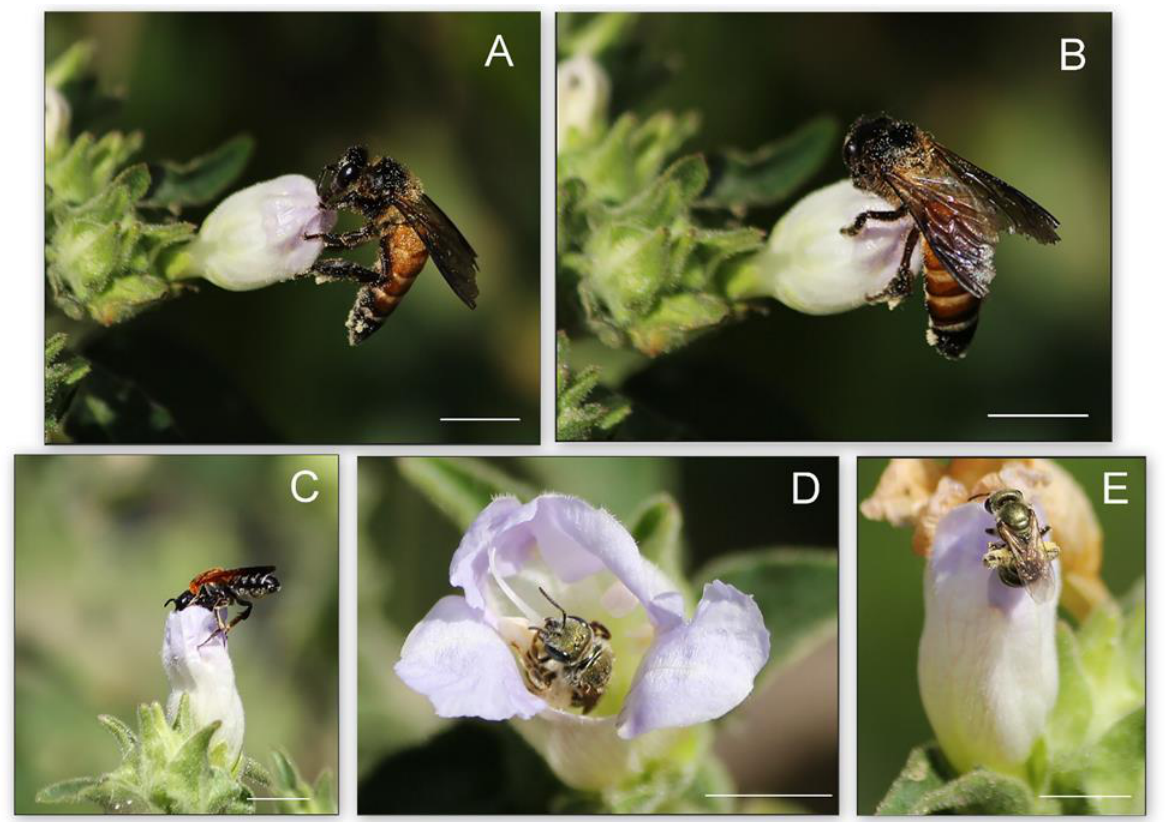
F IGURE 2. The floral visitors engaging in larceny of Strobilanthes ixiocephala buds. (A) and (B) Apis dorsata piercing open the fully enclosed bud from the top. (C) Megachile lanata entering from the top of the bud which is partially open. (D) and (E) Seladonia sp. entering through the partially opened bud and clinging to the stigma. Scale bar: 0.5